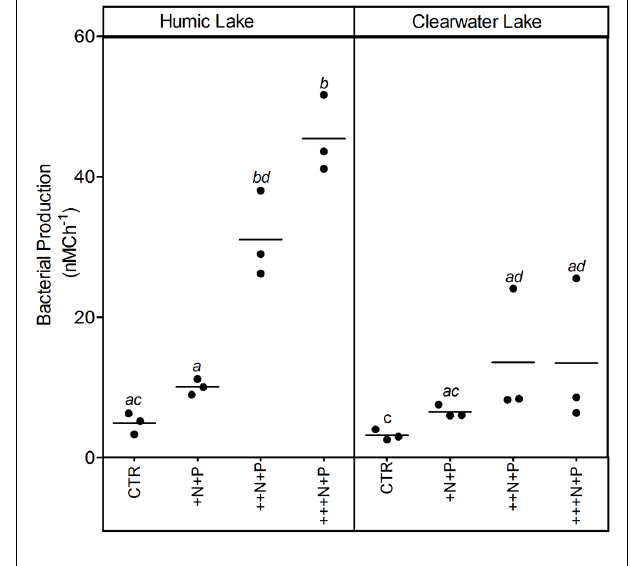
FIGURE 4 | Bacterial production after different N addition for humic and clear waters. Legend as described in Figure 1